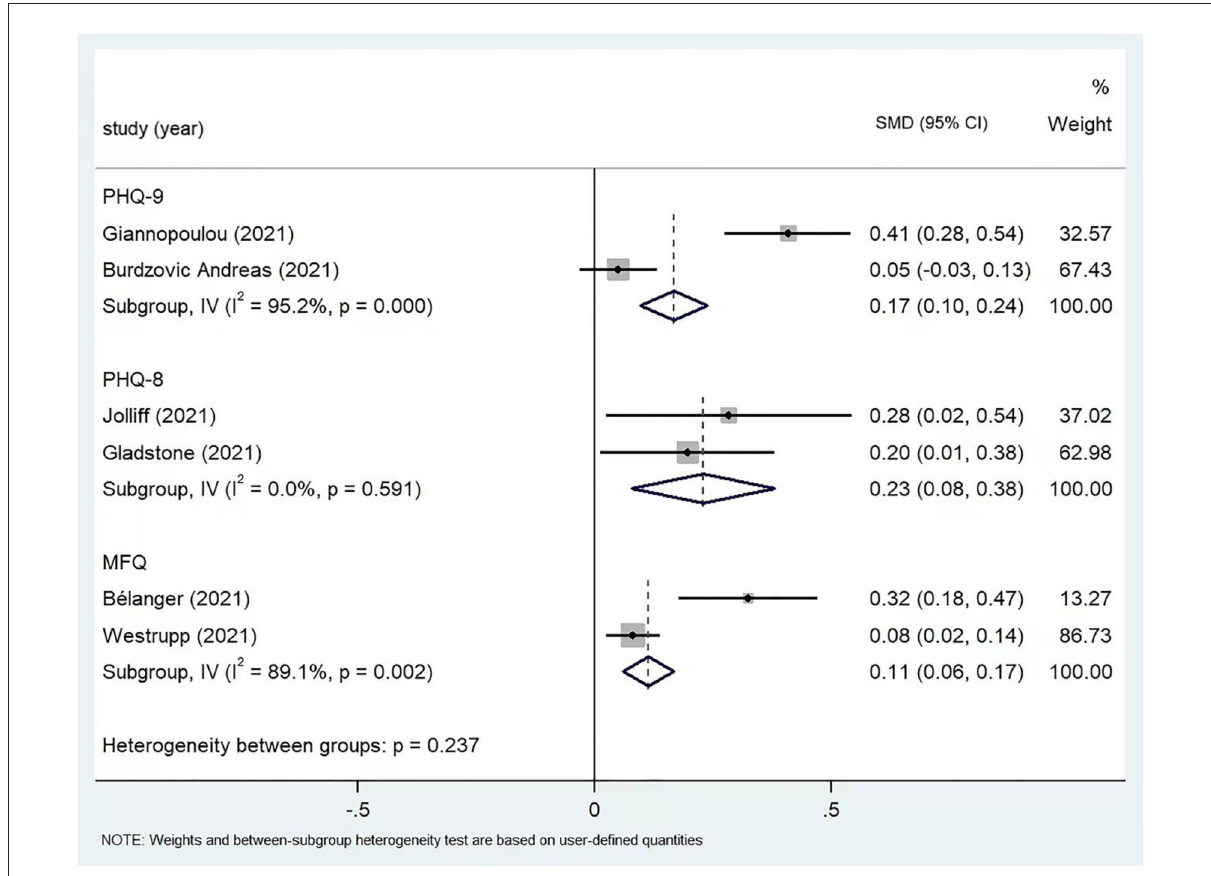
FIGURE4 Subgroup meta-analysis of depression scores by using different scales ( n =